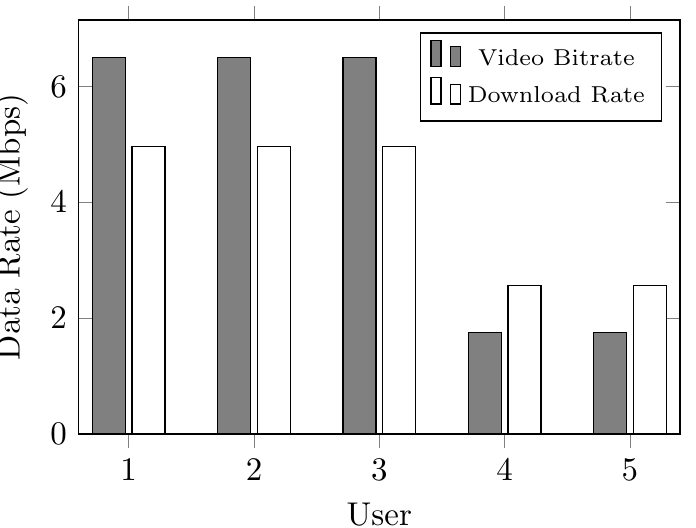
Figure 8. Average download bandwidth for all tested users based on the MAPG-finite strategy with the fairness reward function on 2500 KB/s download link. MAPG-finite assures the same average bandwidths for users with HD preferences, and lower bandwidths for users who desire lower